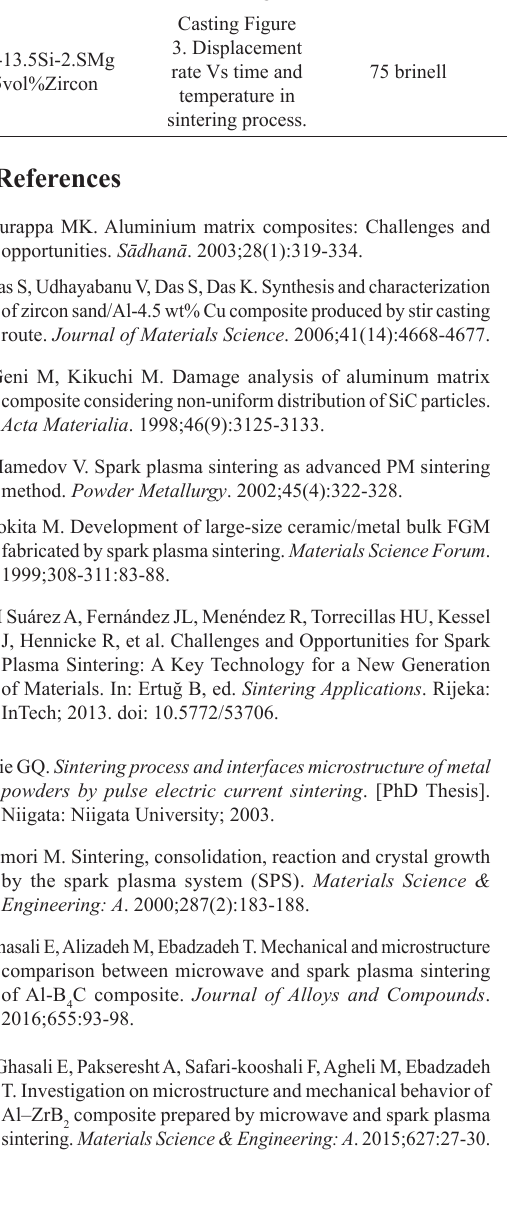
Casting Figure 3.